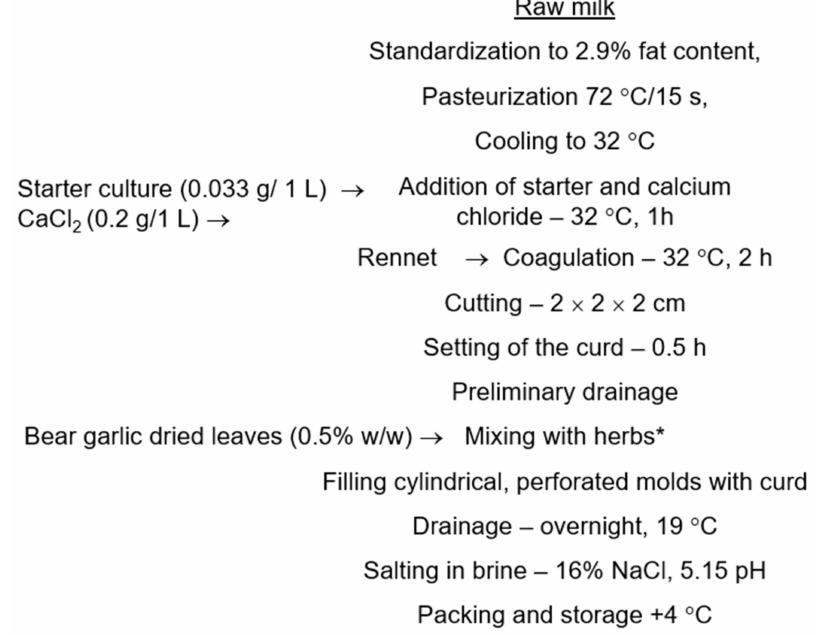
Figure 1. Cheese production procedure (* this stage was omitted during production of the con- trol/natural cheese without